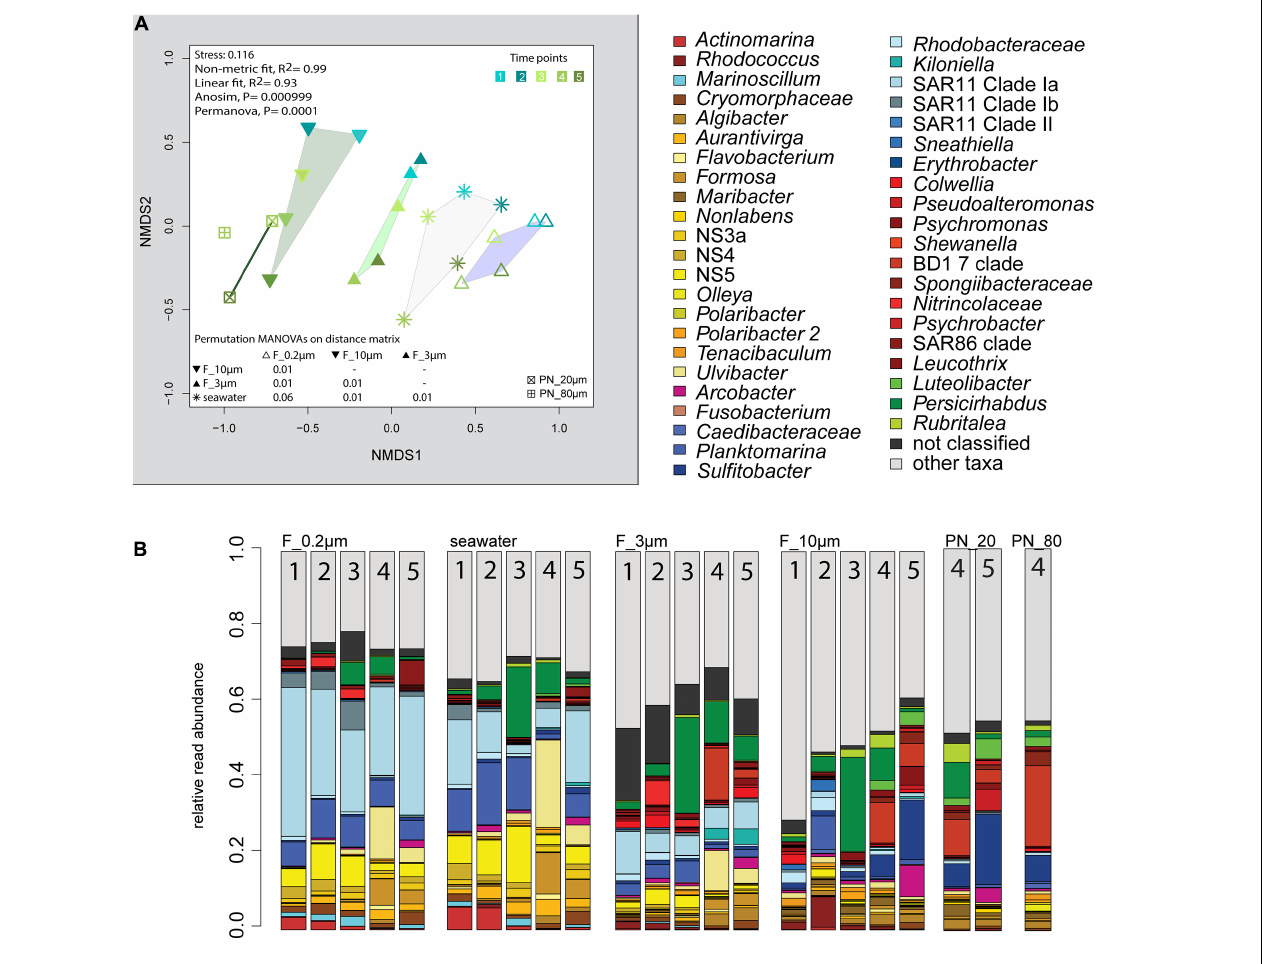
FIGURE 2 | Bacterial community diversity of unfractionated seawater and size-fractionated populations obtained during a phytoplankton spring bloom off Helgoland (North Sea) in 2018. (A) Non-metric multidimensional scaling (NMDS) plot based on Bray–Curtis dissimilarity shows shifts in bacterial communities at five sampling time points (Julian Days 102, 109, 115, 128, and 142). The statistical evaluation is represented by an ANOVA, PERMANOVA, and a pairwise comparison visualized in a distance matrix (n for each group: 5). (B) Stacked bar charts of community composition. Operational taxonomic units (OTUs) shown were among the five most abundant OTUs in at least one sample. Time points are indicated as numbers inside the bars. F_0.2 µ m , filtered fraction ranging from 3 to 0.2 µ m; F_3 µ m , filtered fraction ranging from 10 to 3 µ m; F_10 µ m , filtered fraction > 10 µ m.